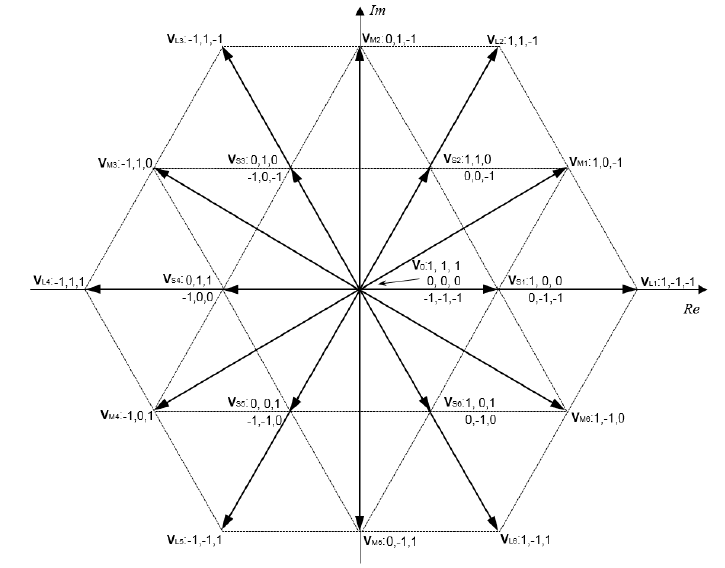
Figure 2. Voltage space vectors in case of balanced